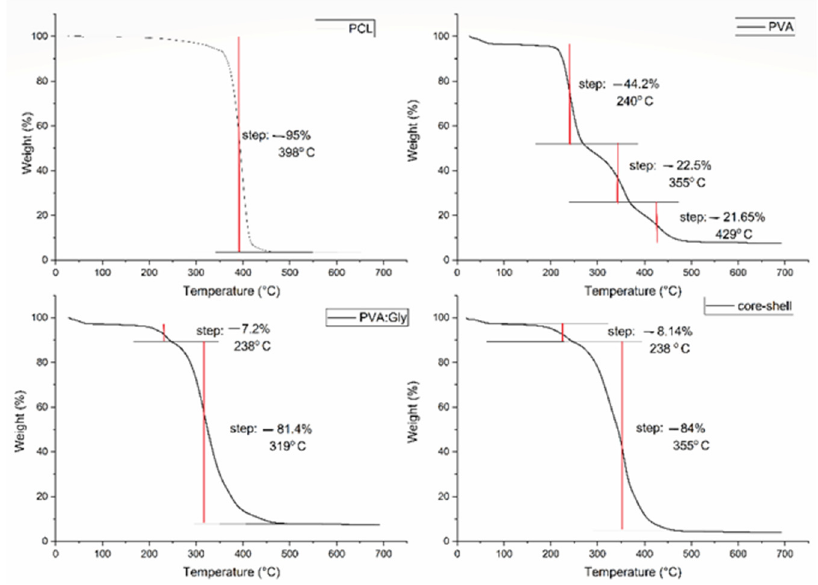
Figure 7. TGA curves of the fabricated PCL, PVA, PVA:Gly, core-shell membranes.